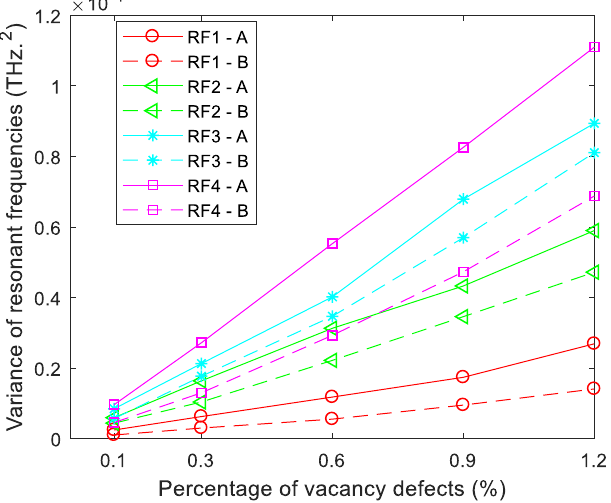
Figure 5. Variance of resonant frequencies for porous graphene (RF1-RF4 are the variance of resonant frequencies in the first- to fourth-order vibration modes; A and B represent the atomic and bond vacancy defects, respectively).